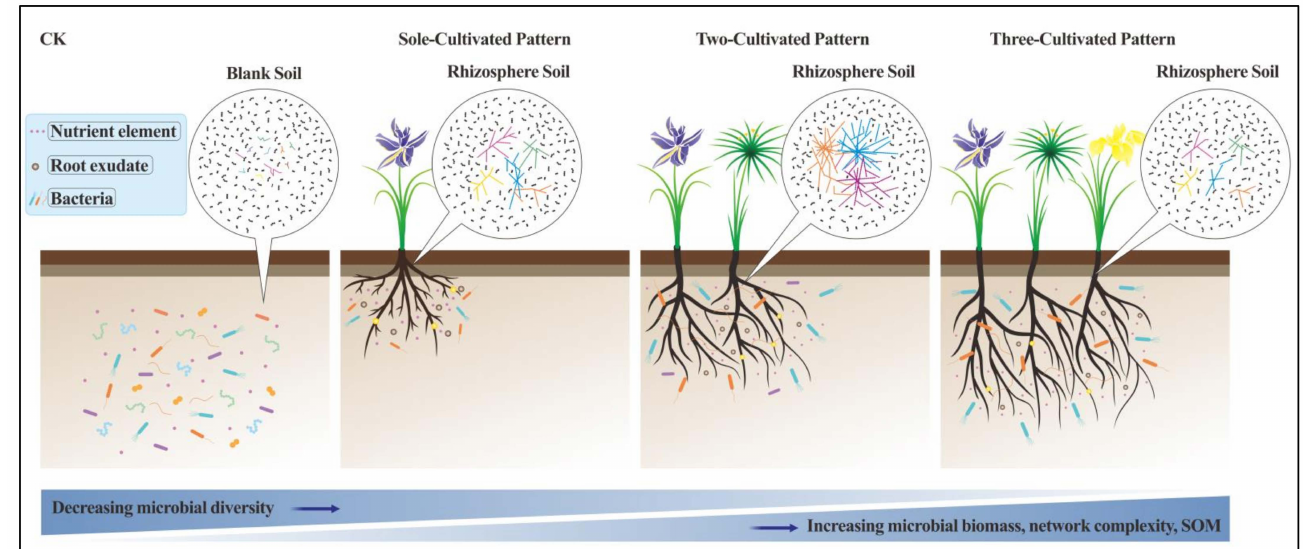
Figure 8. Response mechanism of rhizosphere bacterial community under different cultivation modes. Blank soil has a uniform bacterial community without external interference. Sole-cultivated pattern: During plant growth, organic substances are secreted by the root system to make bacterial communities gather around the root system. Moreover, due to the addition of exogenous Cr, a symbiotic network is established among rhizosphere bacterial communities to resist Cr stress jointly. Under a two-cultivated pattern, the increase of plants can significantly improve the soil microenvi- ronment, increase the rhizosphere bacterial community biomass, and build a complete symbiotic network. Under the three-cultivated pattern, the soil microenvironment is improved, but the symbi- otic relationship between bacteria is weakened. The effects of different cultivation patterns on the soil microenvironment showed that diversity decreased, biomass increased, network complexity increased, and soil organic matter increased, thus effectively improving the soil